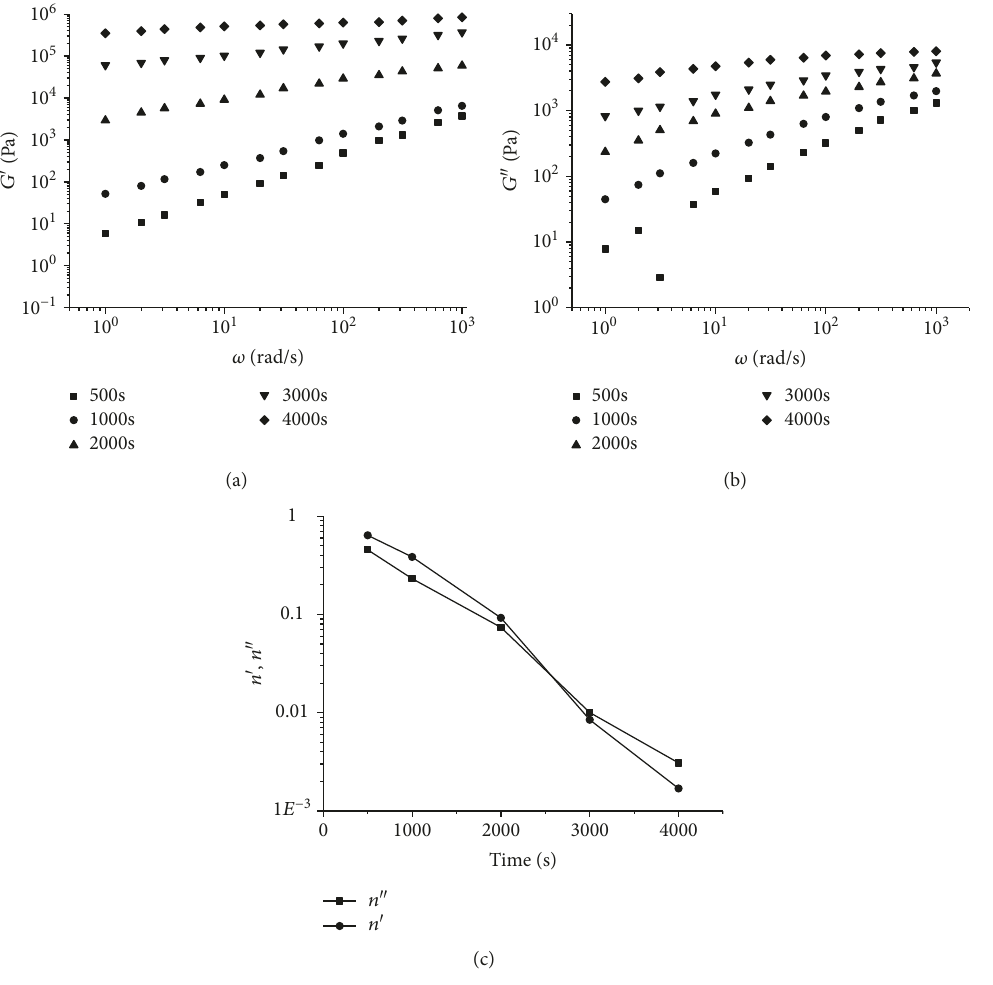
Figure 5: (a) Storage modulus G ′ and (b) loss modulus G ″ versus angular frequency ω at di ff erent aging time intervals for the polythiourethane system at 75 ° C. (c) Time dependence of the exponents n ′ and n ″ determined from linear fi tting of G ′ and G ″ versus angular frequency data (log-log coordinates) in (a) and